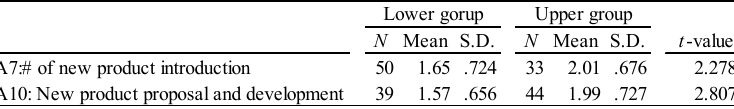
Table 4. Difference in means of openness